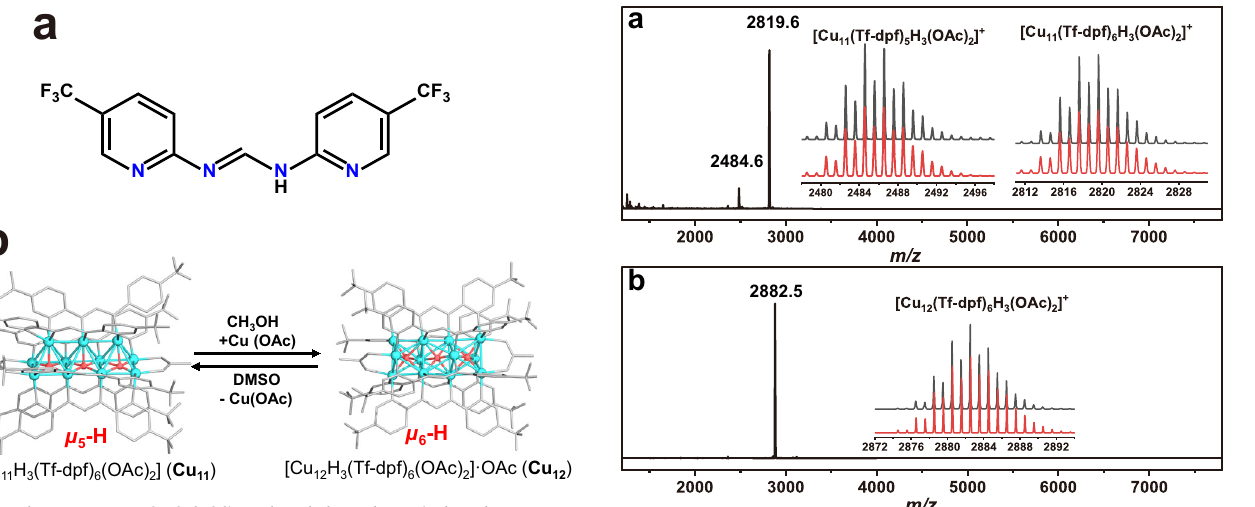
Fig. 1 The structure of Tf-dpf ligand and the solvent-induced interconversion of Cu 11 and Cu 12 . The chemical structure of Tf-dpf ( a ) and the structural transformation between Cu 11 and Cu 12 ( b ). Color legend of b : light blue, Cu; red, Hydride; white, Tf-dpf ligand.